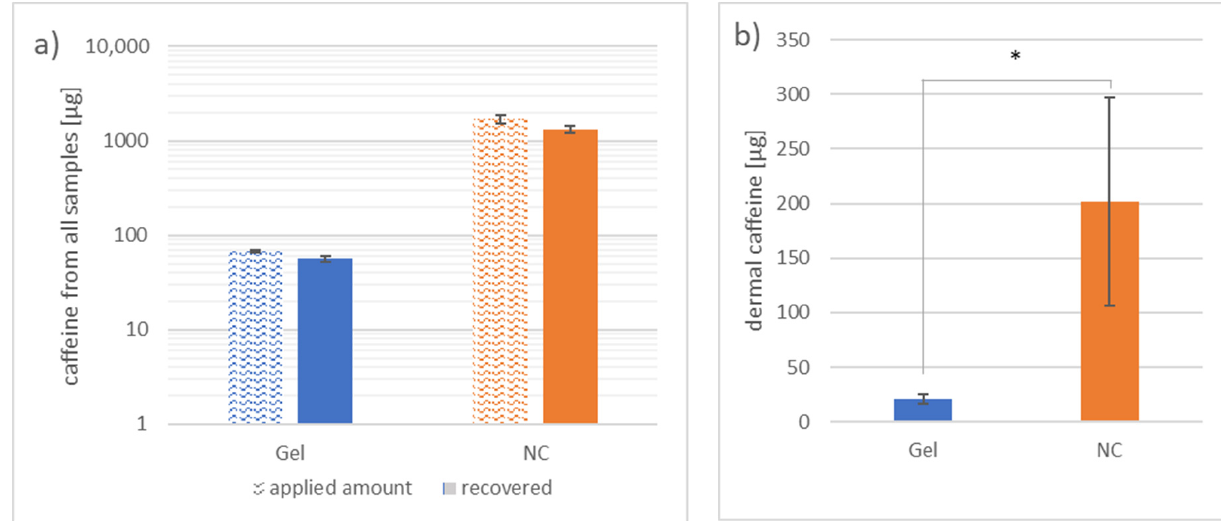
Figure 3. Graph ( a ) shows the overall collected and extracted caffeine from areas where caffeine gel or caffeine nanocrystal gel formulation (NC) was applied in correlation to the total amount of caffeine applied on a logarithmic scale. Graph ( b ) presents the total amount extracted from the dermis by homogenization and microdialysis. Differences between the two areas of p < 0.05 were considered significant (*). n = 5 (applied amount: n = 3).